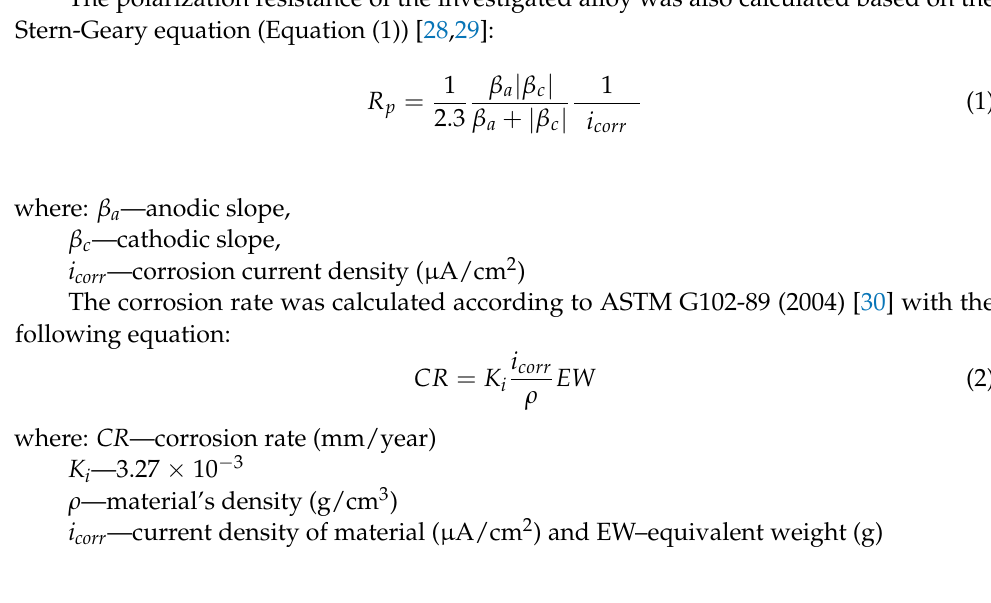
Figure 7. Open circuit potential evolution ( a ) and Tafel plots ( b ) for the CoCrFeNiMo 0.85 HEA ESD coating.